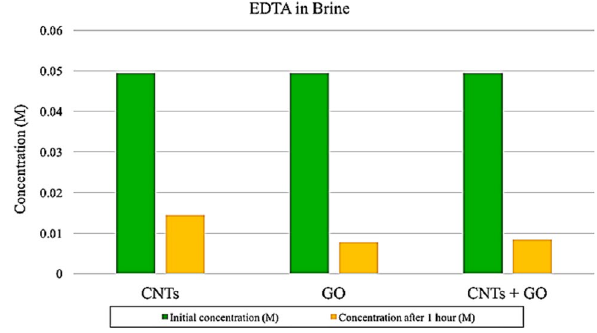
Fig. 4 Concentration of EDTA in brine before and after 1 h of stirring